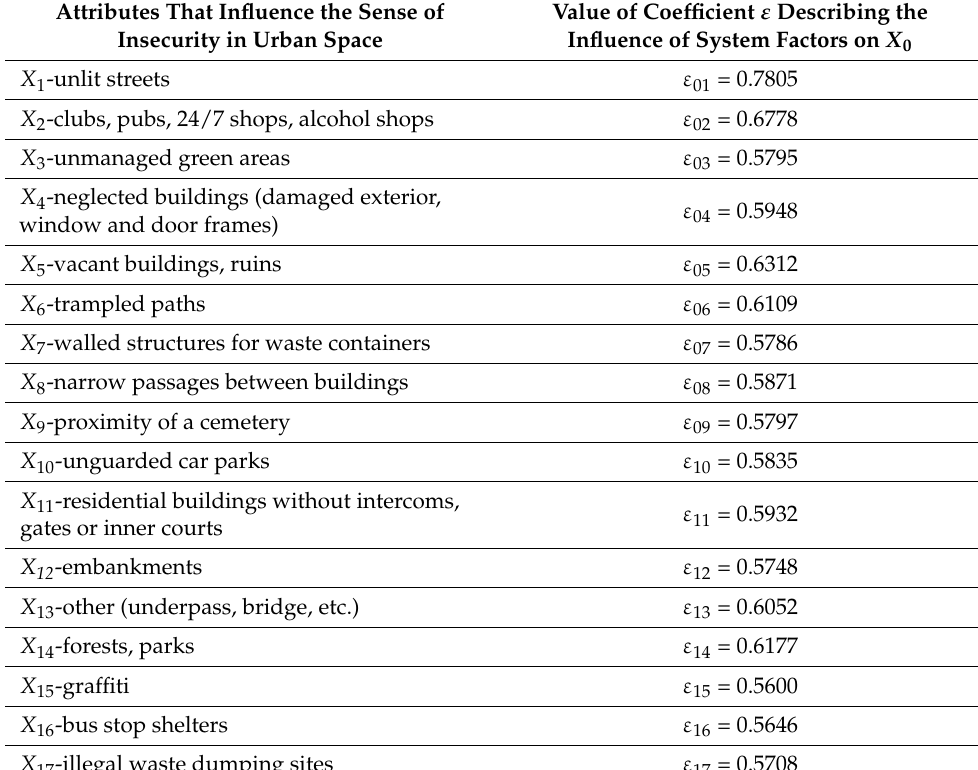
Value of Coefficient ε Describing